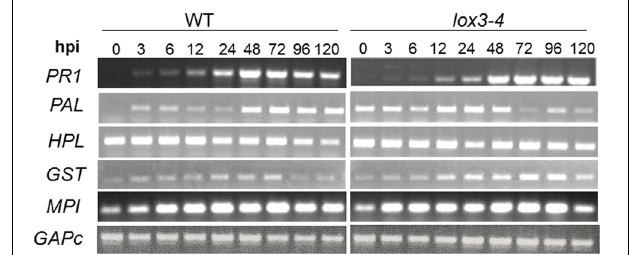
FIGURE 2 | Expression of defense-related genes in leaves of lox3-4 mutant vs B73 NIL (WT) in response to C. graminicola infection. Approximately 3-week-old lox3-4 mutant and WT seedlings at 4 true leaf stage were infected with C. graminicola at 1 × 10 6 spores.ml − 1 .mlnicolaola with with at 4 tTrizol reagent and cDNA synthesized with Ambion 1st strand cDNA synthesis kit. PCR was conducted using standard procedures and the expression of GAPc was used as an internal control. HPL , hydroperoxide lyase; PAL , phenylalanine ammonia lyase; GST , glutathione S-transferase; MPI , maize proteinase inhibitor; PR1 , pathogenesis related protein 1; GAPc , glyceraldehyde-3-phosphate